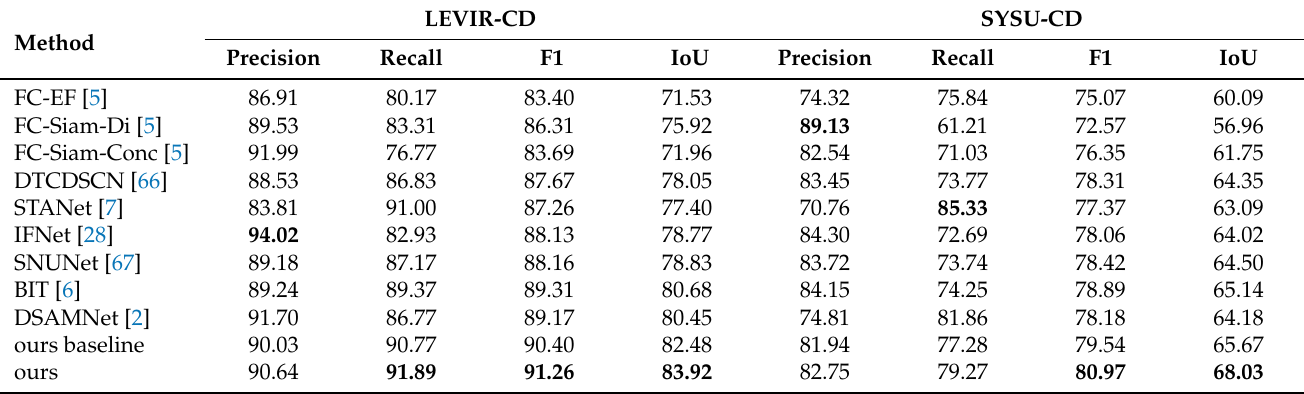
Table 1. Comparison with different SOTA binary change detection